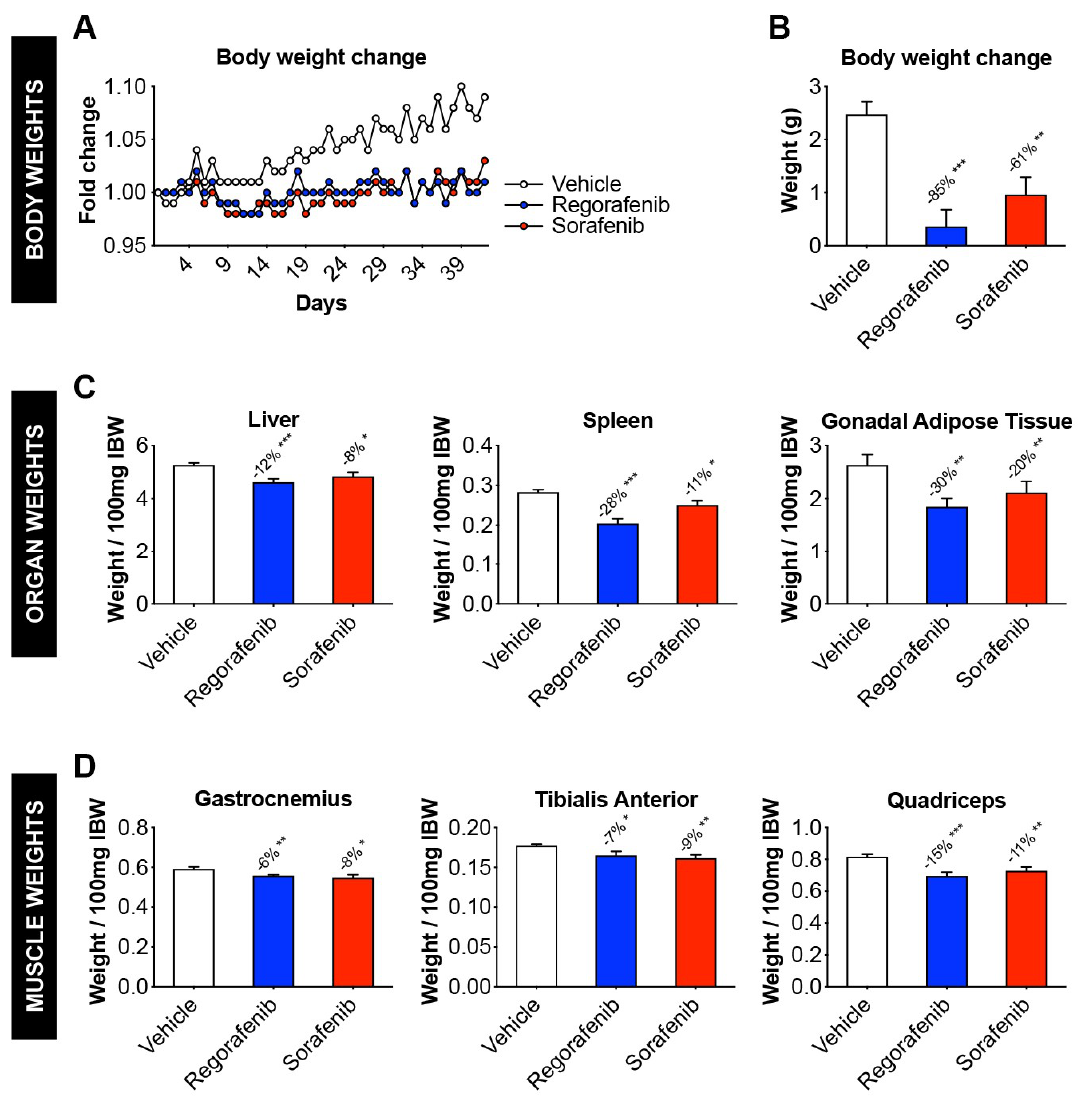
Figure 1. Animals exposed to regorafenib or sorafenib display impaired growth. ( A ) Body weight change (normalized to initial body weight) in mice treated with 30 mg/kg/day regorafenib (blue; n = 8), 60 mg/kg/day sorafenib (red; n = 8), or vehicle (white; n = 8) over the course of 6 weeks. ( B ) Net body weight change (initial to final), expressed in grams. ( C ) Liver, spleen, and gonadal adipose tissue weights (expressed as weight/100 mg Initial Body Weight). ( D ) gastrocnemius, tibialis anterior, and quadriceps muscle weights (expressed as weight/100 mg Initial Body Weight). Data presented as mean ± SEM. Significance of the difference: * p < 0.05, ** p < 0.01, *** p < 0.001 vs. Vehicle.